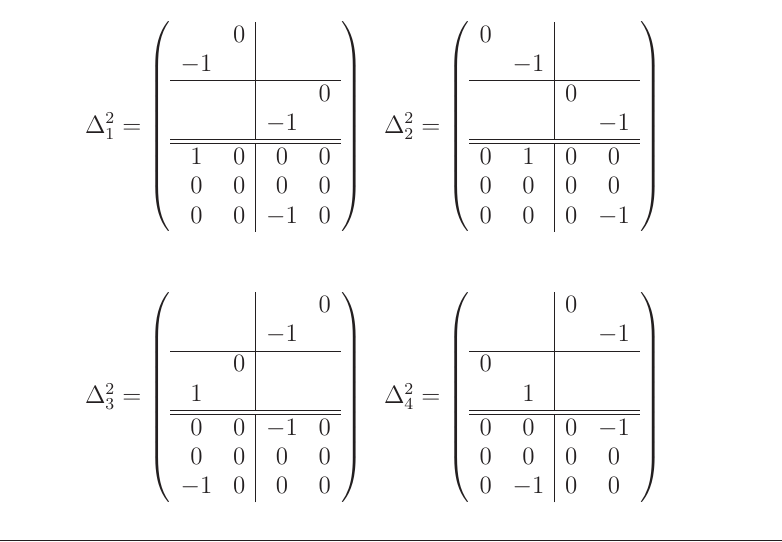
Table 9: The 2-sector space-like down matrices for the Maxwell field-strength multiplet.